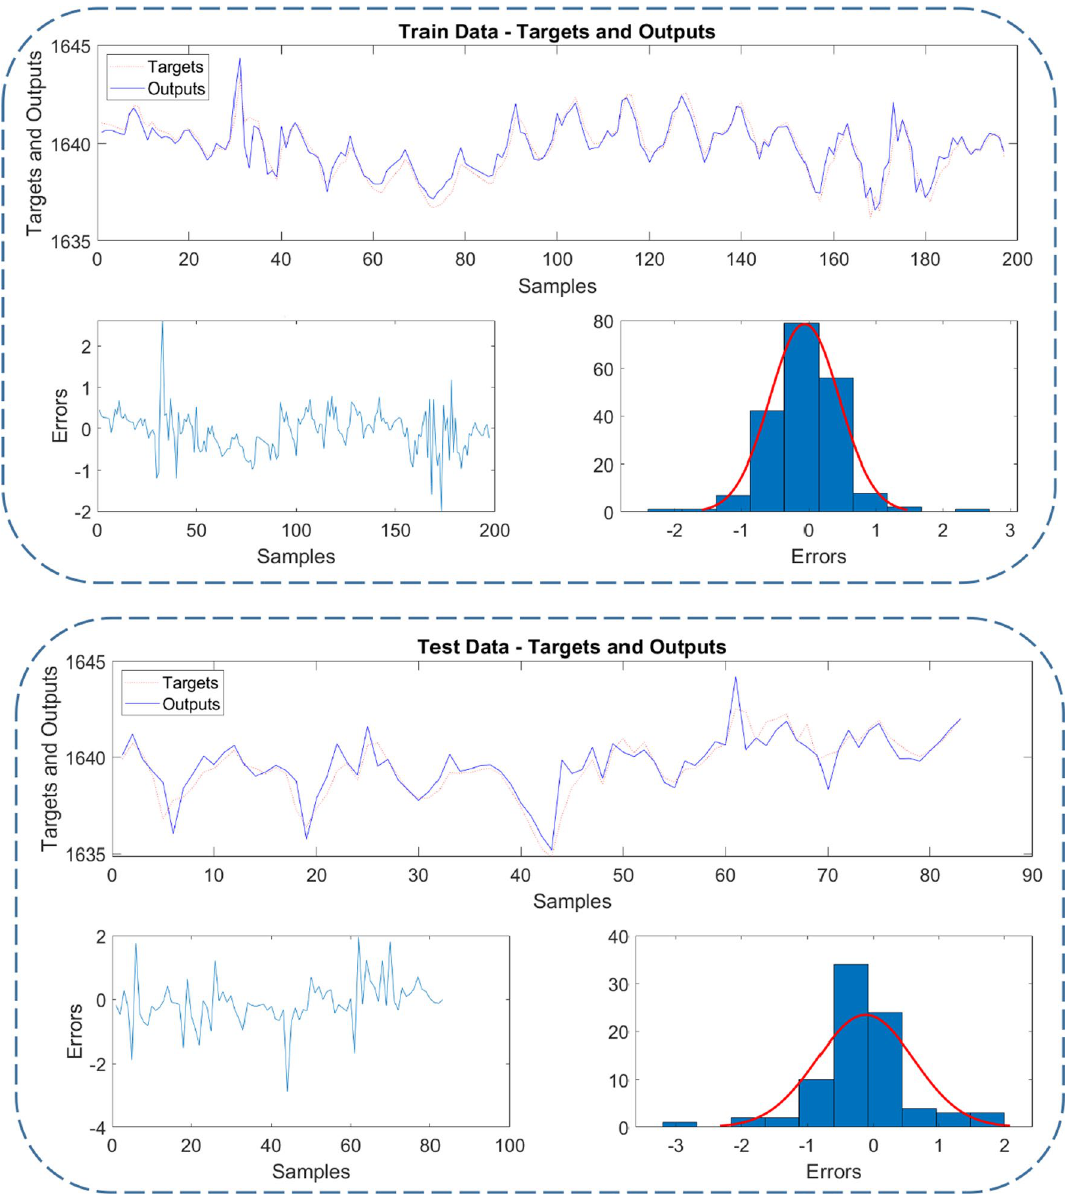
Fig. 7 Time series of predicted values of GWL based on the superior model (ORELM) compared to the observed data in training and testing